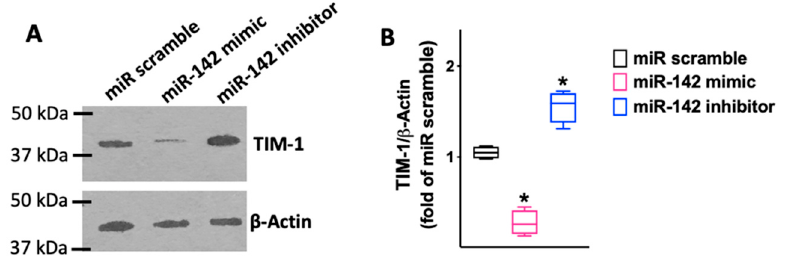
Figure 4. The results obtained via RT-qPCR were confirmed in terms of protein levels ( Biorbyt ; #orb382613; Cambridge, UK), as shown in the representative immunoblots in panel ( A ) and their quantification in panel ( B ). All experiments were performed at least in triplicate; the box-and-whiskers graph indicates the medians and the 5th–95th percentiles; *: p < 0.01 vs. miR scramble.